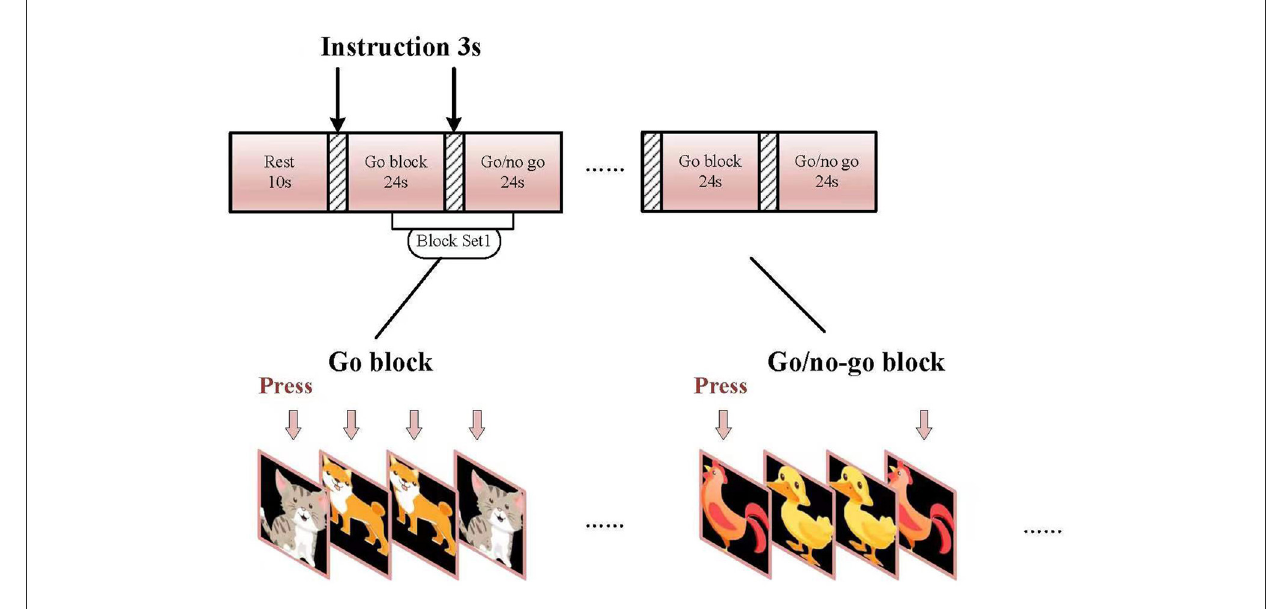
FIGURE1 Experimental design.